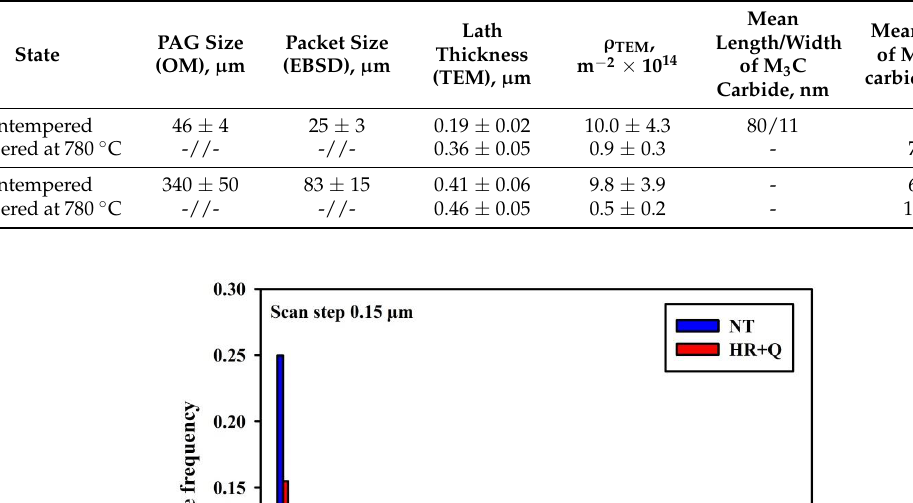
Figure 5. The distributions of grain boundary misorientations in the untempered NT and HR+Q samples.